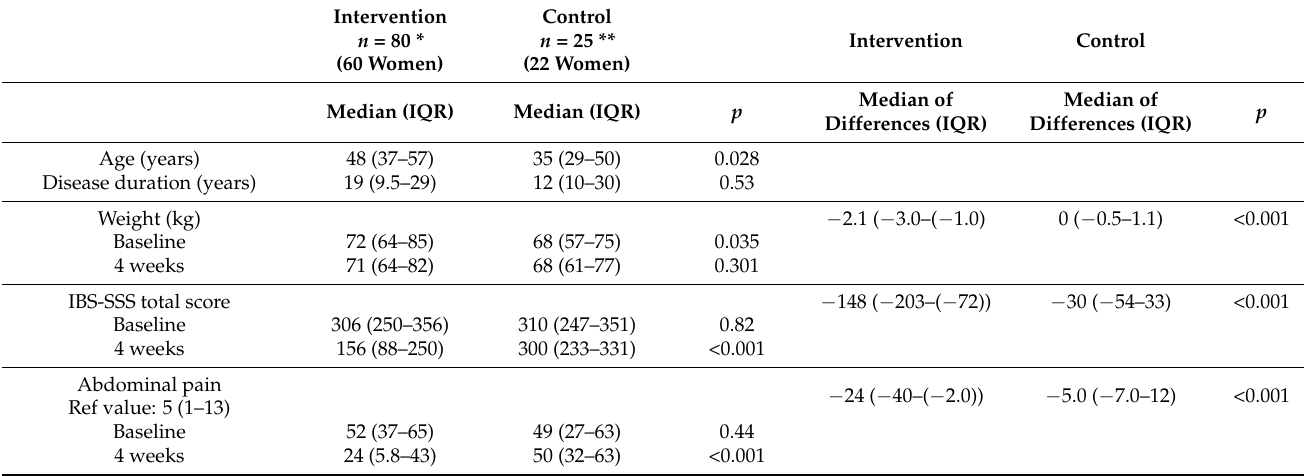
Table 1. Gastrointestinal symptoms and weight before and after the 4-week SSRD